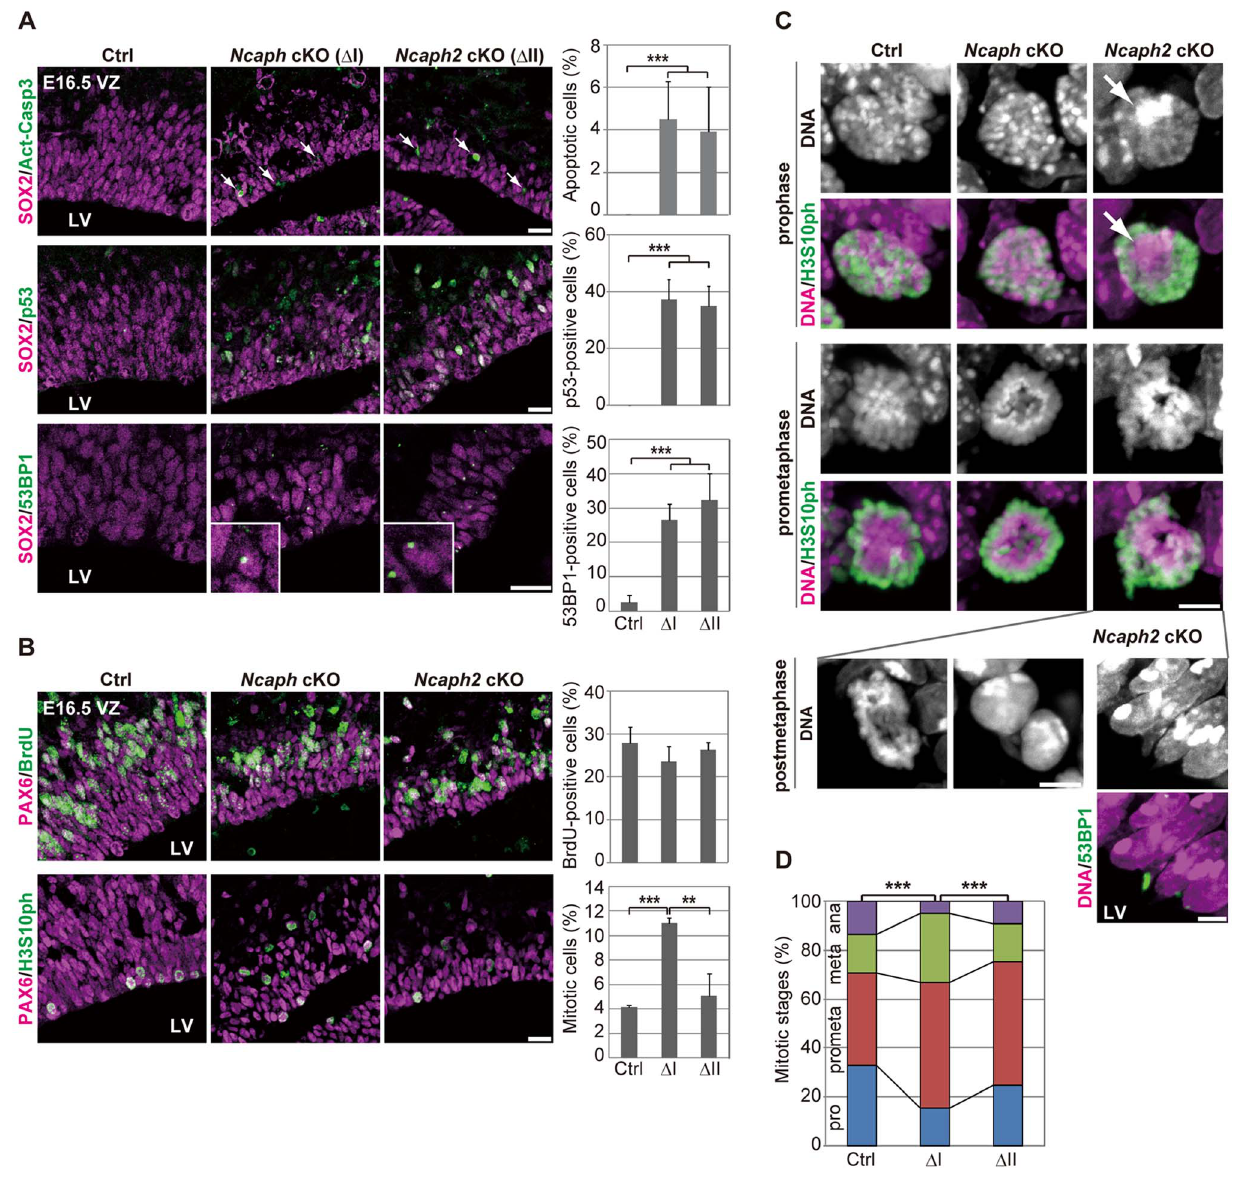
Figure 4. Condensins I and II differentially contribute to NSC divisions and survival. ( A ) Frozen sections of embryonic brains at E16.5 were immunolabeled with antibodies against SOX2 and Act-Casp3 (upper panels), antibodies against SOX2 and p53 (middle panels) or antibodies against SOX2 and 53BP1 (lower panels). The insets show close-ups of 53BP1-positive cells observed in cKO mice. The data shown are from a single representative experiment out of three repeats. Sections from three different embryos of each genotype were analyzed. Bars, 20 m m. The percentages of positive cells in the VZ were measured in the dorsal area of cortices at E16.5, and plotted in the right. Data were obtained from four independent sections from two different embryos. The bars indicate the mean and SD. *** P , 0.001 ( t -test with a Holm correction for multiple comparisons). ( B ) One hour after injecting mice at E16.5 with BrdU, frozen sections were prepared and immunolabeled with antibodies against BrdU and PAX6, an NSC marker (upper panels). Alternatively, NSCs in mitosis were visualized by H3S10ph labeling (lower panels). The data shown are from a single representative experiment out of three repeats. Sections from two different embryos of each genotype were used for BrdU incorporation assay and from three different embryos of each genotype were labeled with H3S10ph antibody. Bar, 20 m m. The percentages of BrdU-positive or mitotic cells in the PAX6-positive population were measured and plotted in the right. All data were obtained from three independent sections. The bars indicate the mean and SD. ** P , 0.01, *** P , 0.001 ( t -test with a Holm correction for multiple comparisons). ( C ) Prophase and prometaphase chromosomes on the apical surface of the VZ were immunolabeled with H3S10ph antibody, and their morphologies were analyzed by Hoechst staining. A large Hoechst-dense structure observed in Ncaph2 cKO mice at prophase is shown by the arrow. Chromatin bridges in anaphase or postmitotic cells were observed only in Ncaph2 cKO mice (postmetaphase panels). Tail-like chromatin structures in postmitotic cells were immunolabeled with an antibody against 53BP1. The data shown are from a single representative experiment out of three repeats. Sections from three different embryos of each genotype were analyzed. Maximum intensity projections are shown. Bars, 5 m m. ( D ) Mitotic stages were determined based on chromosome morphologies, and their distributions were plotted. Data were obtained from two different embryos (at least 98 mitotic chromosomes scored). *** P , 0.001 (Chi-squared test).